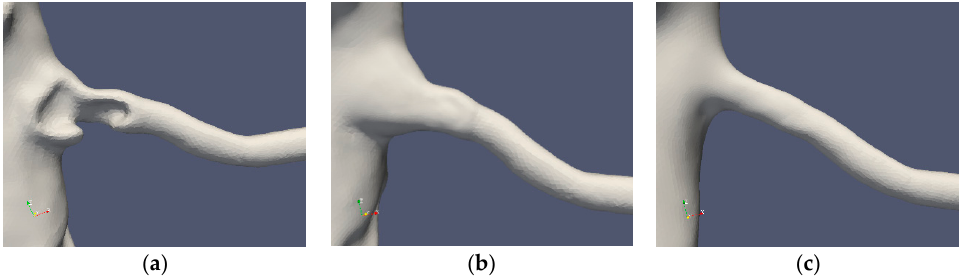
Figure 3. Case2 segmentations: original ( a ), reconstructed ( b ) and smoothed ( c ).